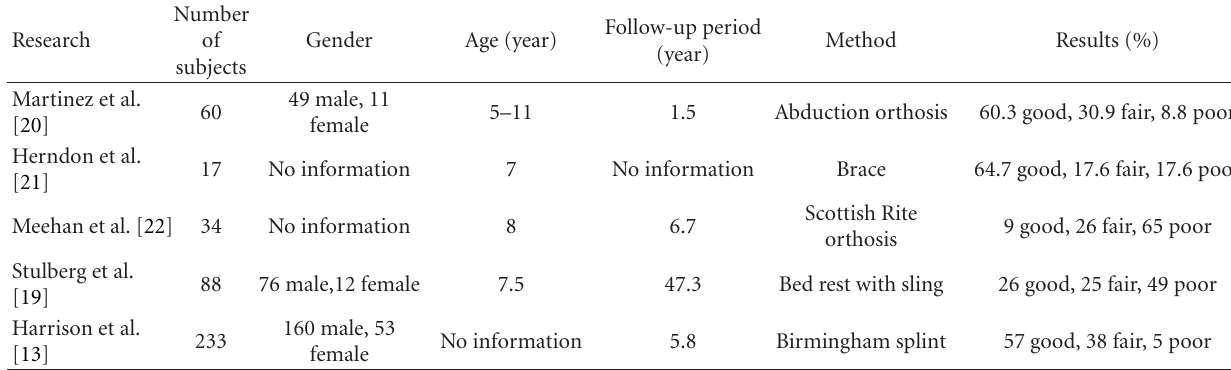
Table 4: Results of containment research studies.